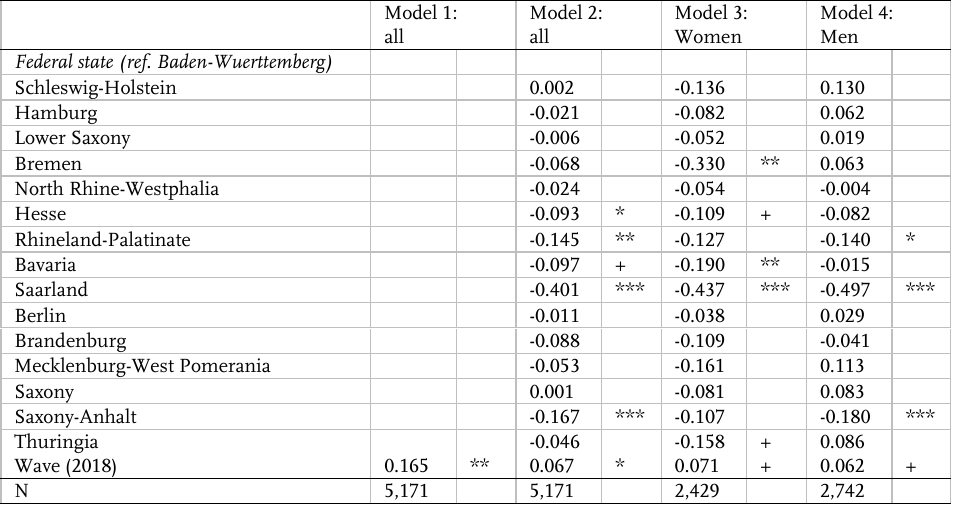
Table A.2 : Results from logistic regression (1: Labour market participation; 0: No labour market participation), pooled models and models by gender, average marginal effects (AME)